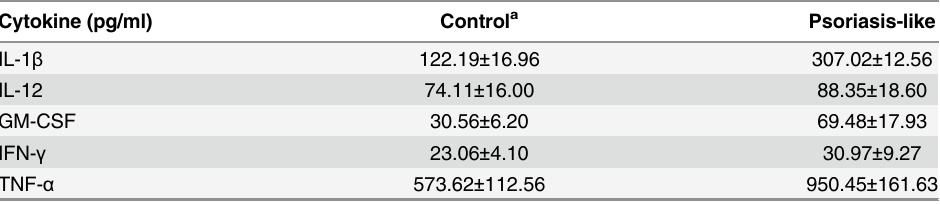
Table 1. Cytokine levels in normal and psoriatic